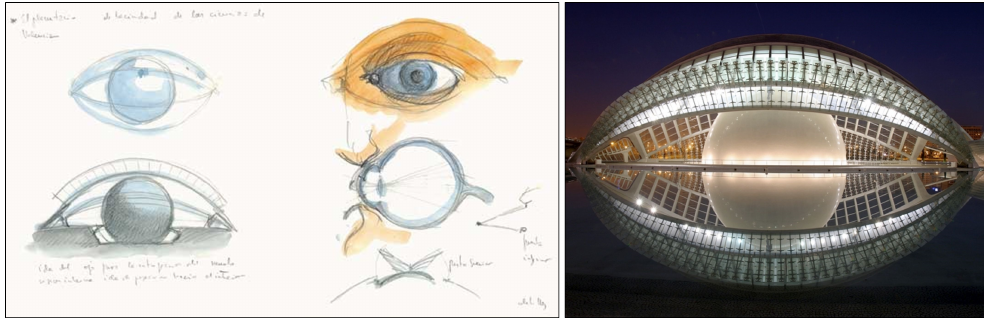
Figure 1. Drawings by Santiago Calatrava and L’Hemisfèric in Valencia (Spain)